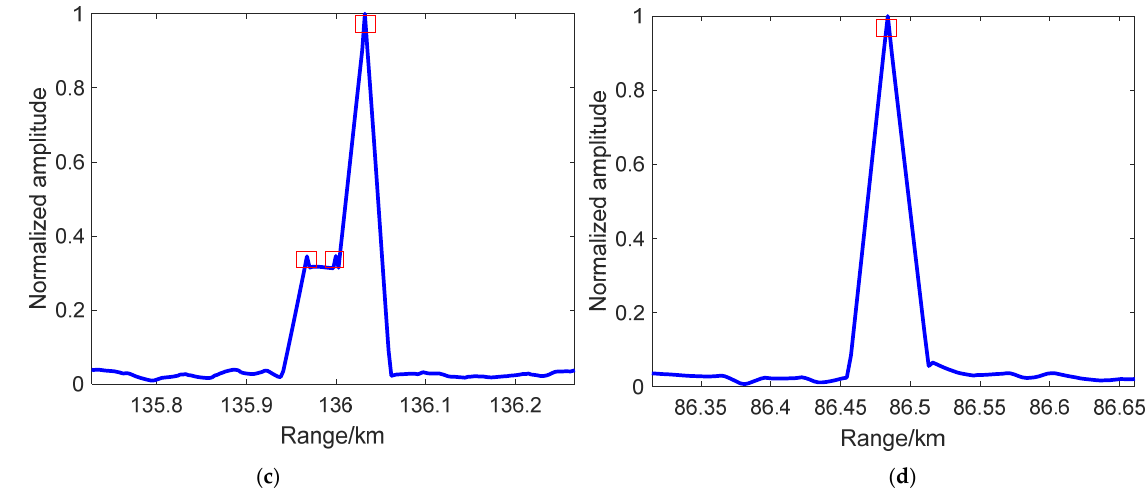
Figure 9. One-dimensional range detection results of point target 3 under the detection of 4 BDS satellites with 33-meter echo sampling: ( a ) satellite 1; ( b ) satellite 2; ( c ) satellite 3; and ( d ) satellite 4.